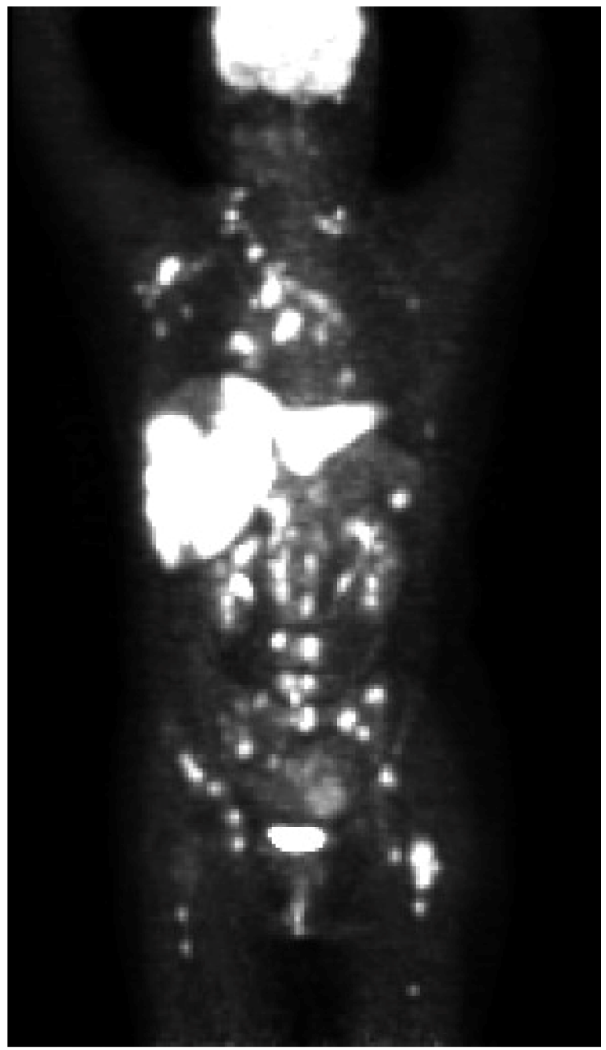
Figure 1. FDG-PET/CT performed before treatment. The figure shows FDG uptake in multiple lesions (liver, bone, and lymph node lesions). FDG-PET/CT: fluorine-18-2-deoxy-d-glucose positron emission tomography and computed tomography.